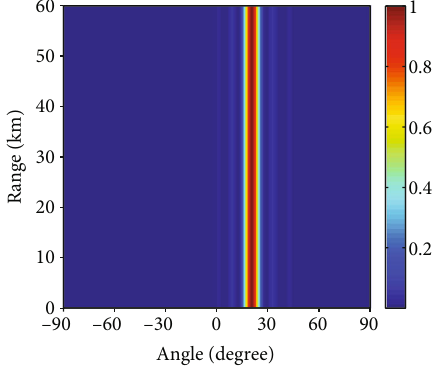
Figure 6: Receive